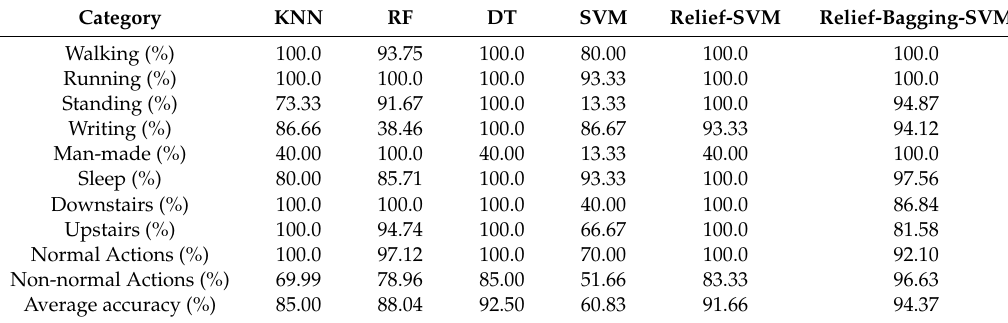
Table 6. Action recognition and classification accuracy.